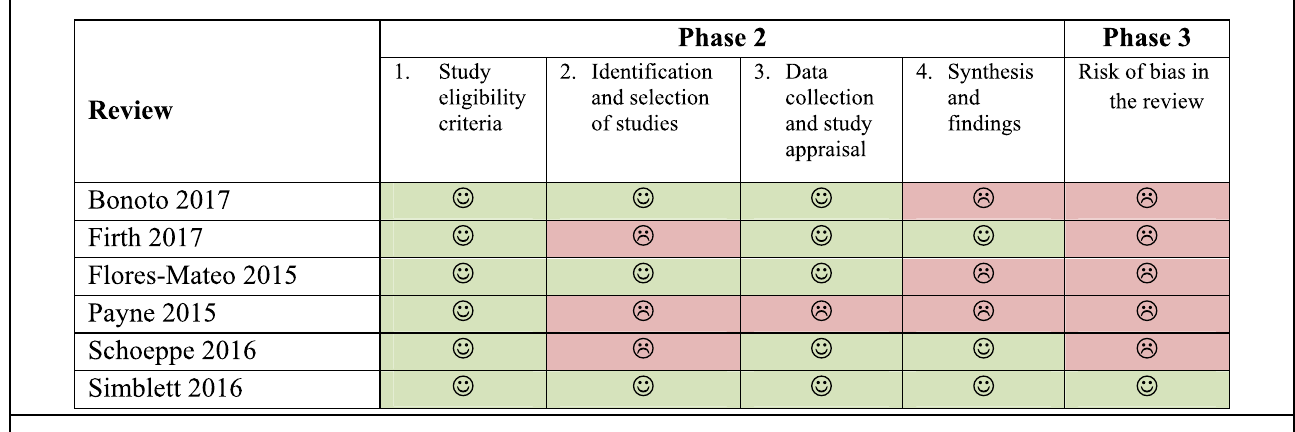
Table 3. Overall results of risk of bias in systematic reviews (ROBIS)